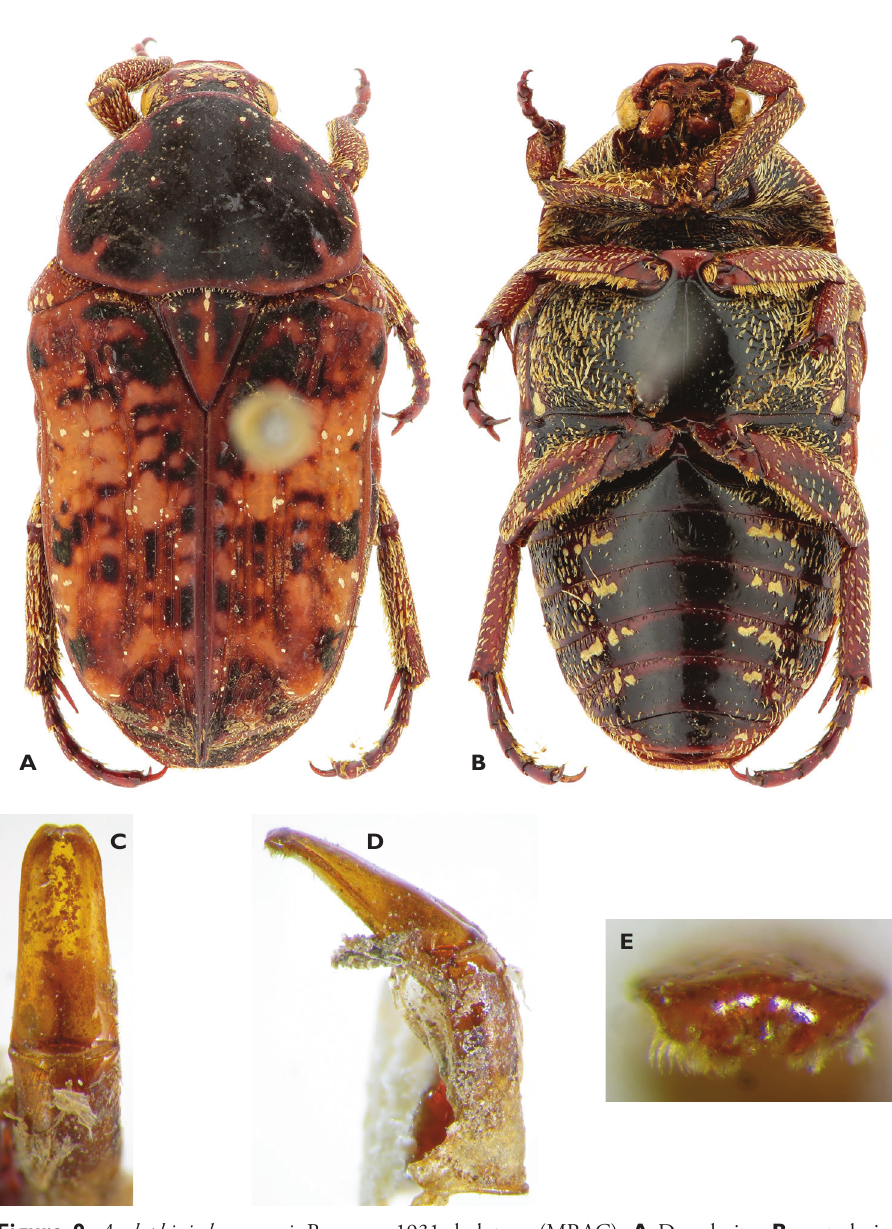
Figure 9. Anelaphinis kwangensis Burgeon, 1931, holotype (MRAC). A Dorsal view B ventral view C parameres in dorsal view D parameres in lateral view E apex of